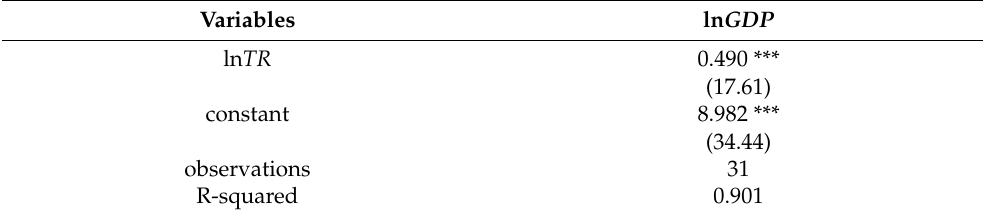
Table 6. Robustness test